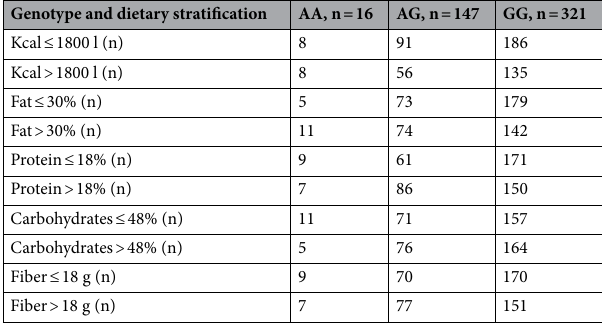
Table 3. The study group stratified by genotypes ans daily dietary